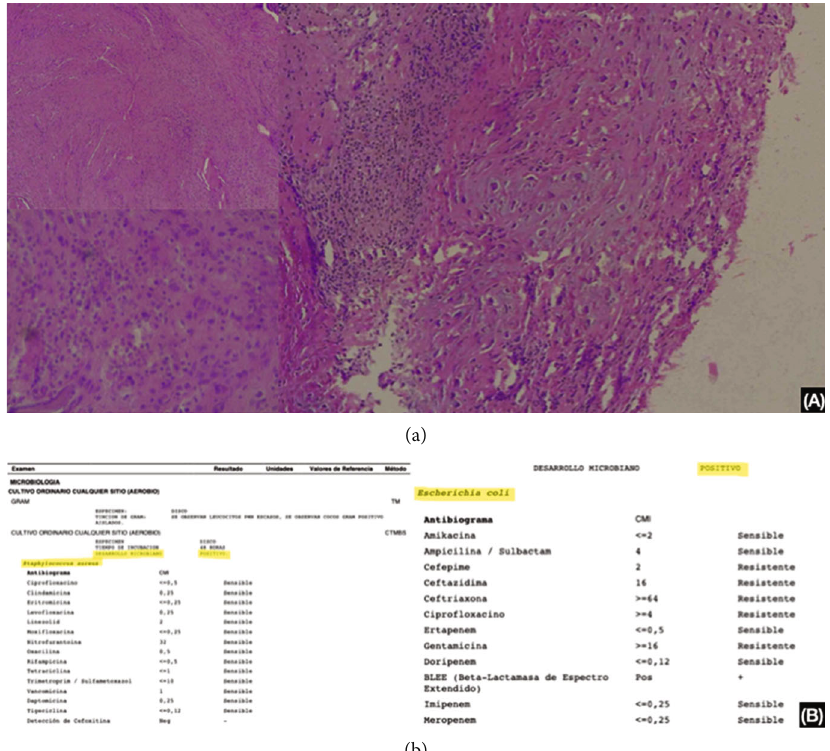
Figure 3: (a) Pathology report of T6-T7 intervertebral disc shows extensive fi brosis with mixed in fl ammatory in fi ltration, bone and cartilage fragments, and reactive-looking atypia. There was no evidence of granulomas. (b) Cultures isolated Escherichia coli extended-spectrum beta- lactamases (ESBL) and Gram-positive cocci Staphylococcus aureus